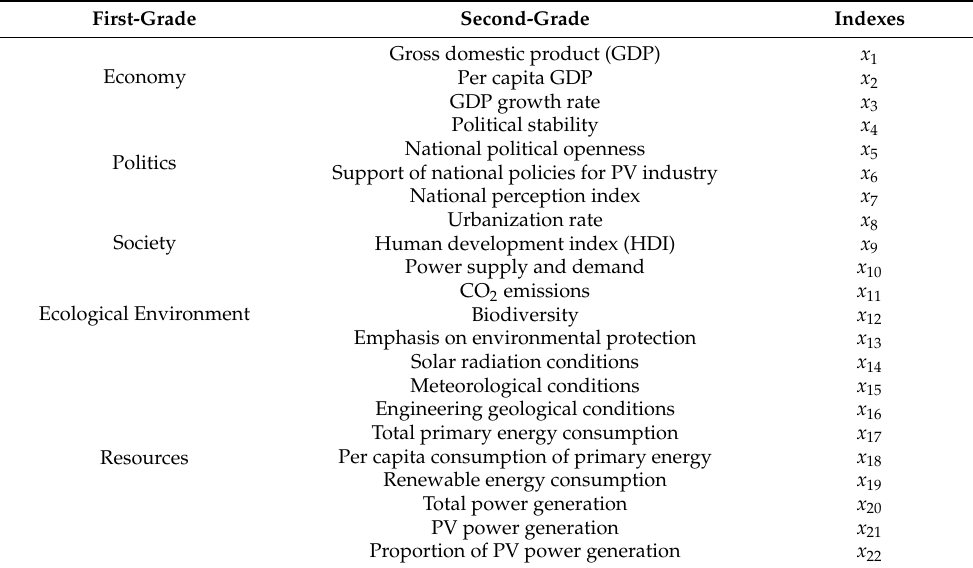
Table 1. Index system of sustainability evaluation in countries along the Belt and